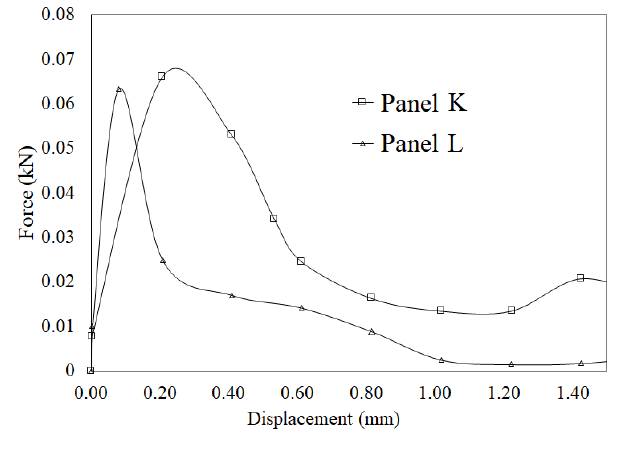
Figure 25. Adhesion force obtained with the shear test.